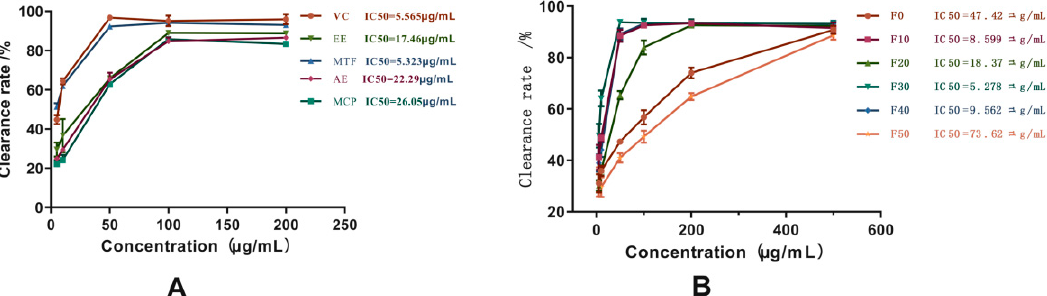
Figure 3. DPPH radical scavenging test results. ( A ) DPPH free radical scavenging ability of alcohol extracts and aqueous extracts before and after purification. ( B ) DPPH radical scavenging ability of the fractional eluent. Data are expressed as mean ± standard deviation ( n = 5).